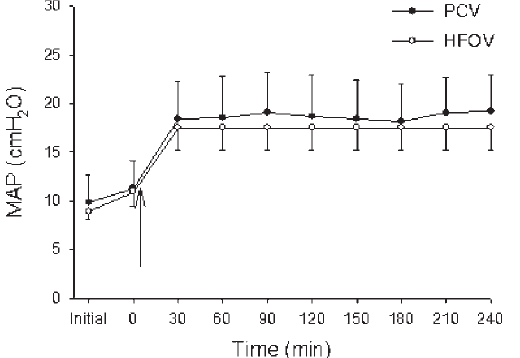
Figure 1 - Animals from PCV group (closed circles) and HFOV group (open circles) were ventilated with MAP around 18 cm H in mean± SD. Both ventilation strategies resulted in similar mean airway pressures (MAP). “Initial” time are values before lung lavage; “zero” time corresponds to values immediately after the installation of the experimental model. The arrow indicates the moment of LIP determination and beginning of both ventilatory strategies